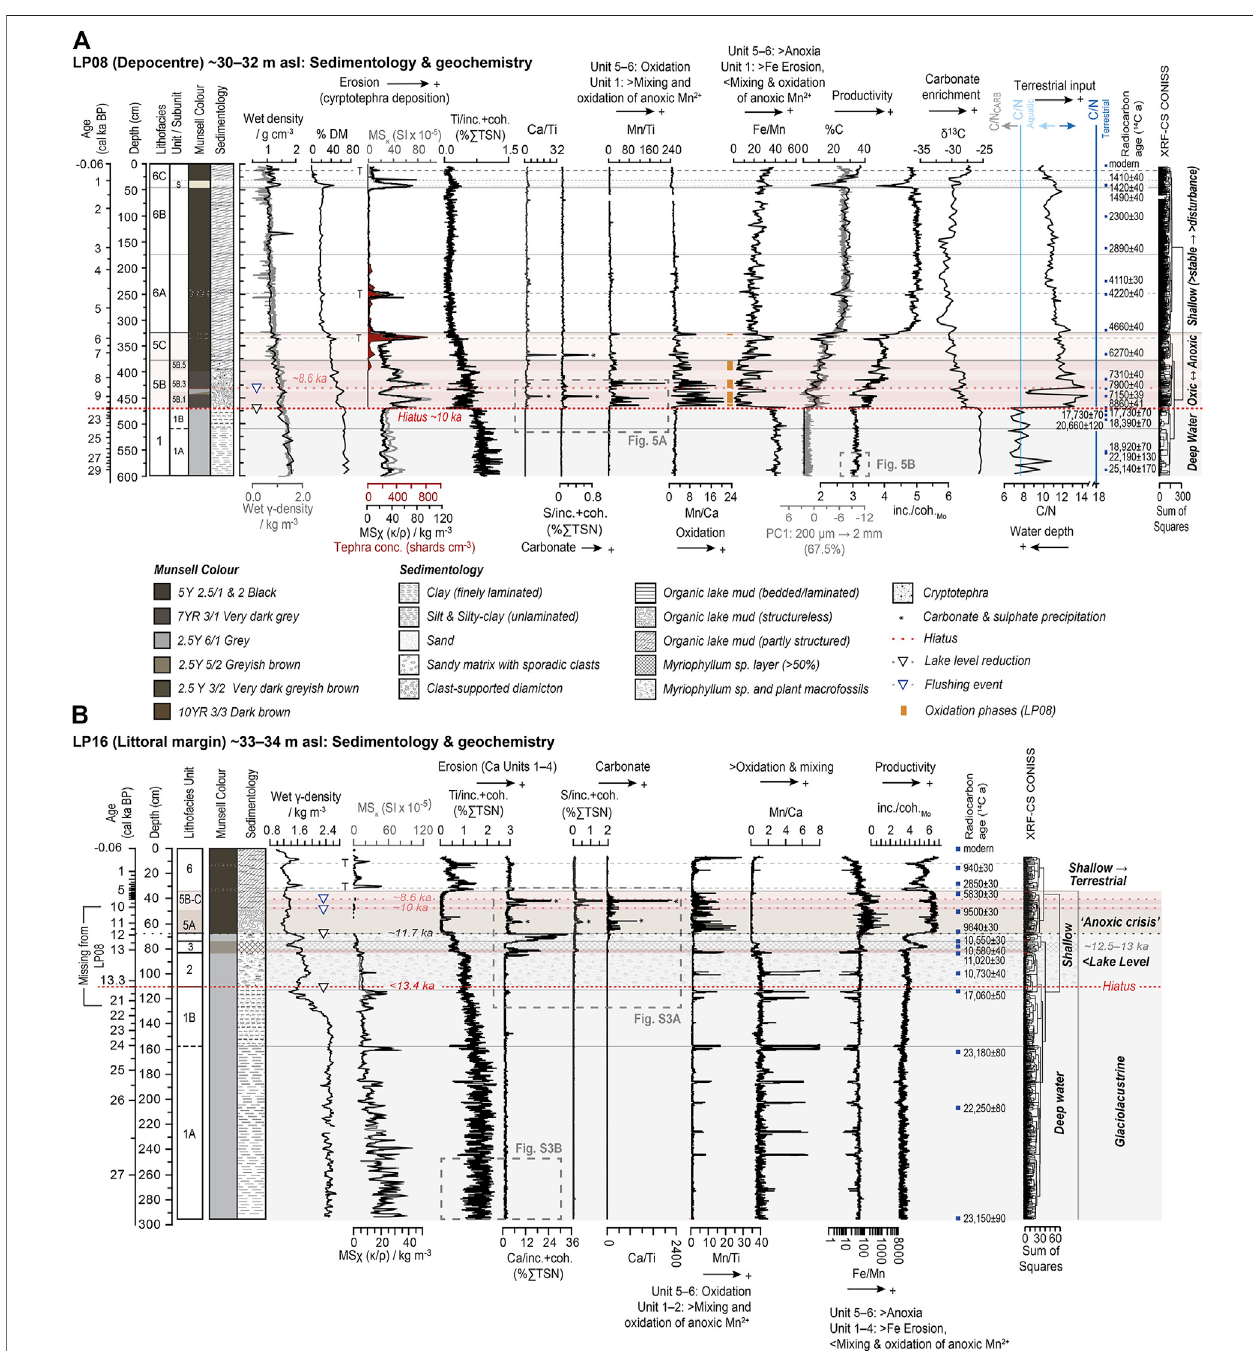
FIGURE 5 | Summary sedimentology and geochemistry data for Lago Pato sediment records. (A) LP08 (depocentre site). (B) LP16 (littoral-catchment site). This fi gureintegratessedimentologicalobservations,keycorescanningparameters,ratios,andsubsampledataandshowsthemainchangesinkeyelements(Ti,Mn,Ca,Fe) and their ratios in both records. Data points between 68 and 62 cm in the LP08 record were not plotted or included in the analysis due to low counts from an extrusion- related surface gap. Data were plotted in C2 (Juggins, 2007) and R, with the fi nal layout achieved in Adobe Illustrator.